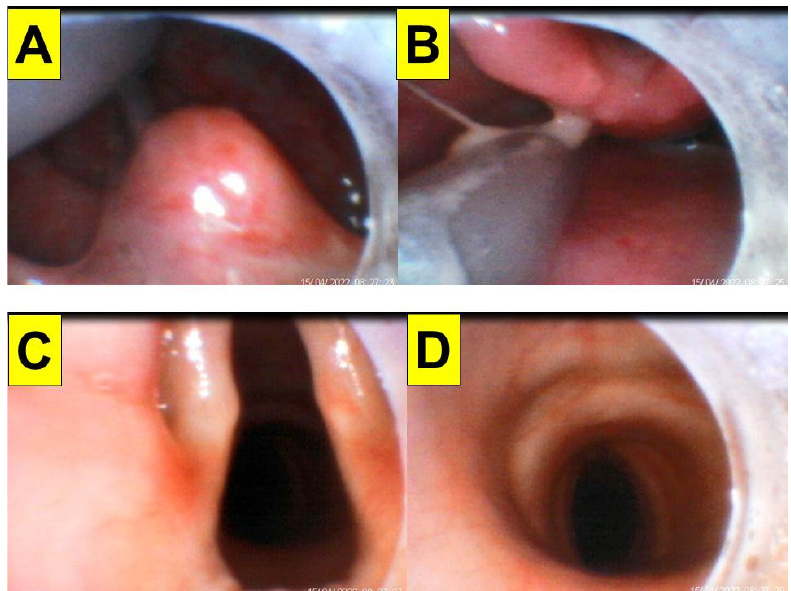
Figure 8. Various views displayed at the video monitor of the intubating stylet through a piece of plastic sheet barrier. ( A ) Entry into oral cavity with identified uvula; ( B ) partial view of pharyngeal- laryngeal space and arytenoid cartilages; ( C ) vocal cords; ( D ) view inside the trachea. The tip of a suction tube was seen in ( A , B ). The time for intubation (from lip to trachea) is 7 s (see also the video clip in the Supplementary Materials Video S3).